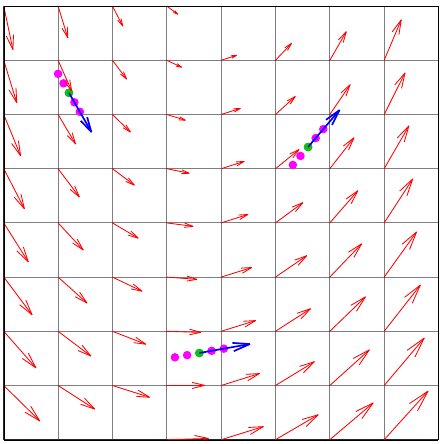
Figure 7. Vector field of the uncertainties extension.